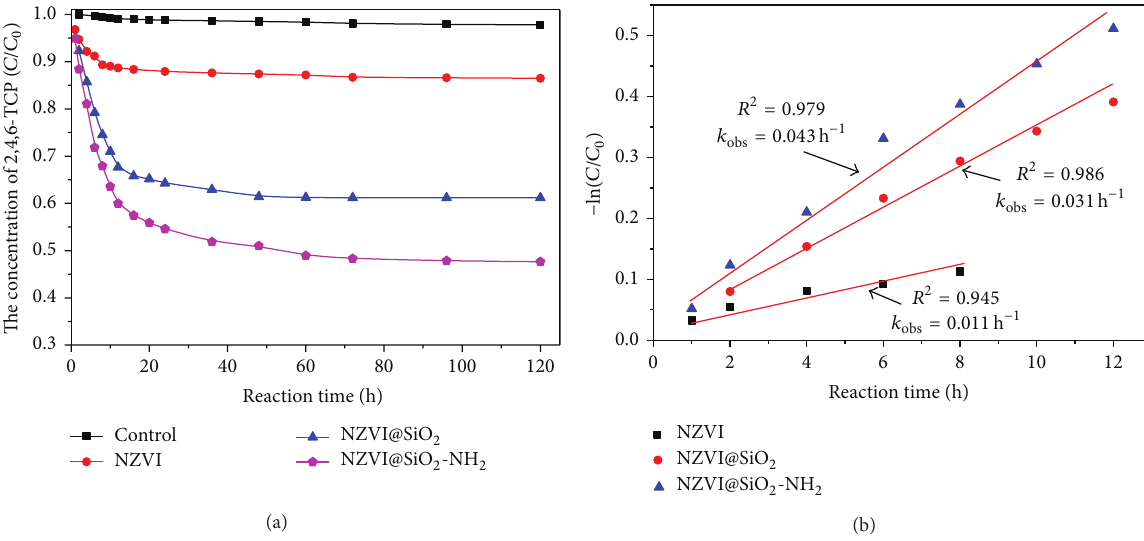
Figure 4: (a) The degradation of 2,4,6-TCP under different iron nanoparticle systems; (b) reaction kinetic plots for the degradation of 2,4,6- TCP versus